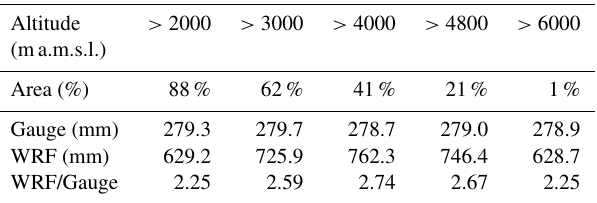
Table 3. The winter precipitation (December–March) from WRF and Gauge above different